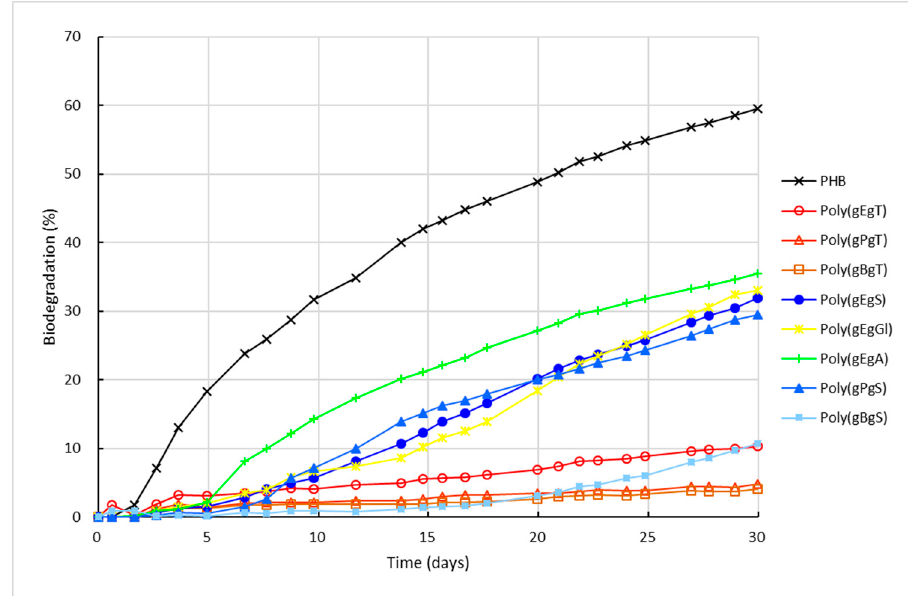
Figure 3. Biodegradation of the poly(ester amide)s in seawater.